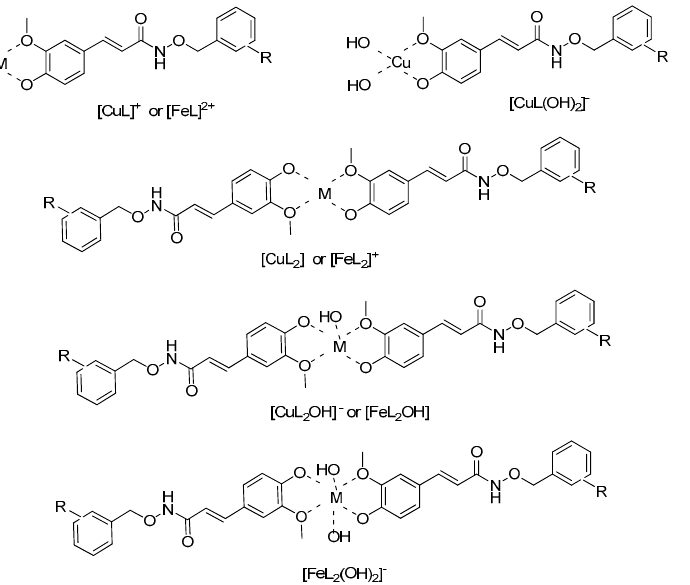
Figure 4. Proposed coordination modes for the complexes of Fe 3+ and Cu 2+ with compounds 1a and 1d .